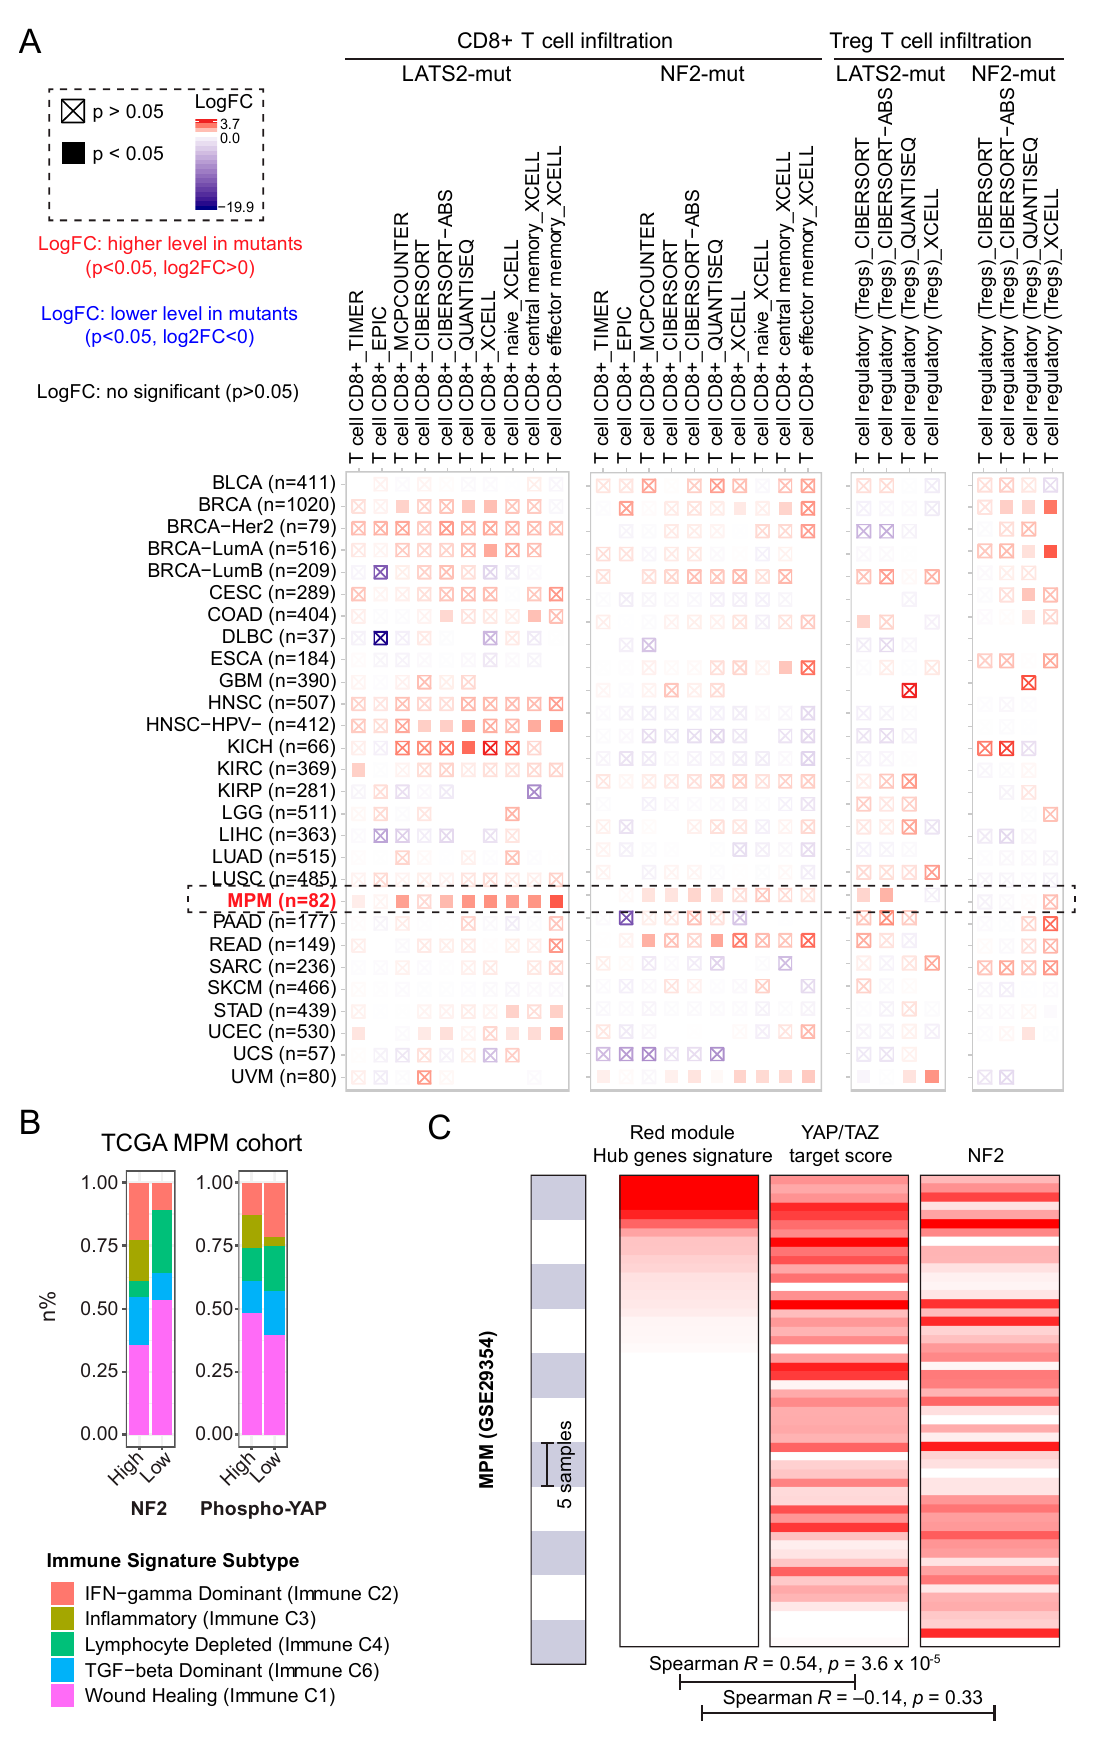
Figure 4. Dysregulation of NF2 and Hippo ‐ YAP exhibits different infiltrative immune signatures in MPM. ( A ) Tumor ‐ infiltrating immune cell profiles across the TCGA pan ‐ cancer cohort were shown. The number of patients shown in parentheses. Data were downloaded from TIMER (ver ‐ sion 2.0), a comprehensive resource for systematic analysis of immune infiltrates across diverse cancer types (http://timer.comp ‐ genomics.org/) (See the methods). ( B ) Percentage of immune sub ‐ type models (C1–C6) across the TCGA MPM cohort, in which the reverse ‐ phase protein